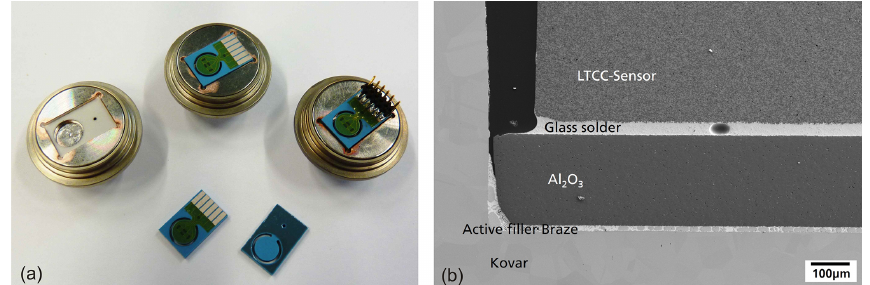
Figure 13. Joint components showing the stepwise integration procedure (a) and a SEM image of a cross section of a packaged LTCC pressure sensor (b) .